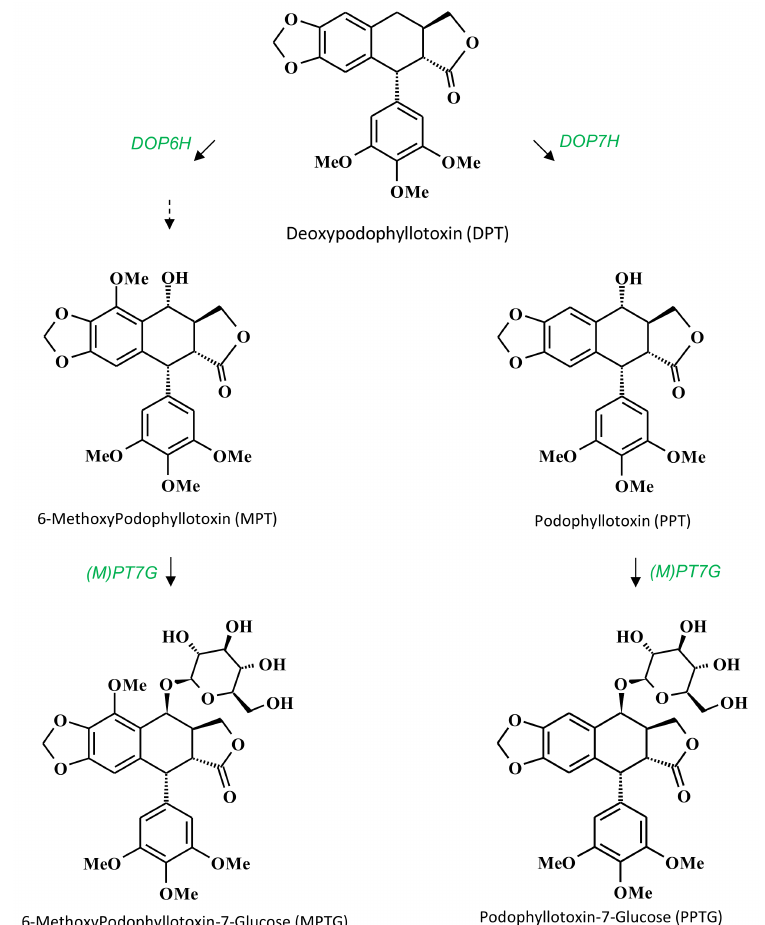
Figure 1. Structures of the main ATL (aryltetralin lignan) and the corresponding putative biosynthetic pathway leading from DPT to PPTG and MPTG in L. flavum . DOP6H: DPT-6-hydroxylase, DOP7H: DPT-7-hydroxylase, (M)PT7G: MPT- and/or PPT-7-glucosyltransferase, DPT: deoxypodophyllotoxin, MPT: methoxypodophyllotoxin, MPTG: methoxypodophyllotoxin-7-glucoside, PPT: podophyllotoxin, PPTG: